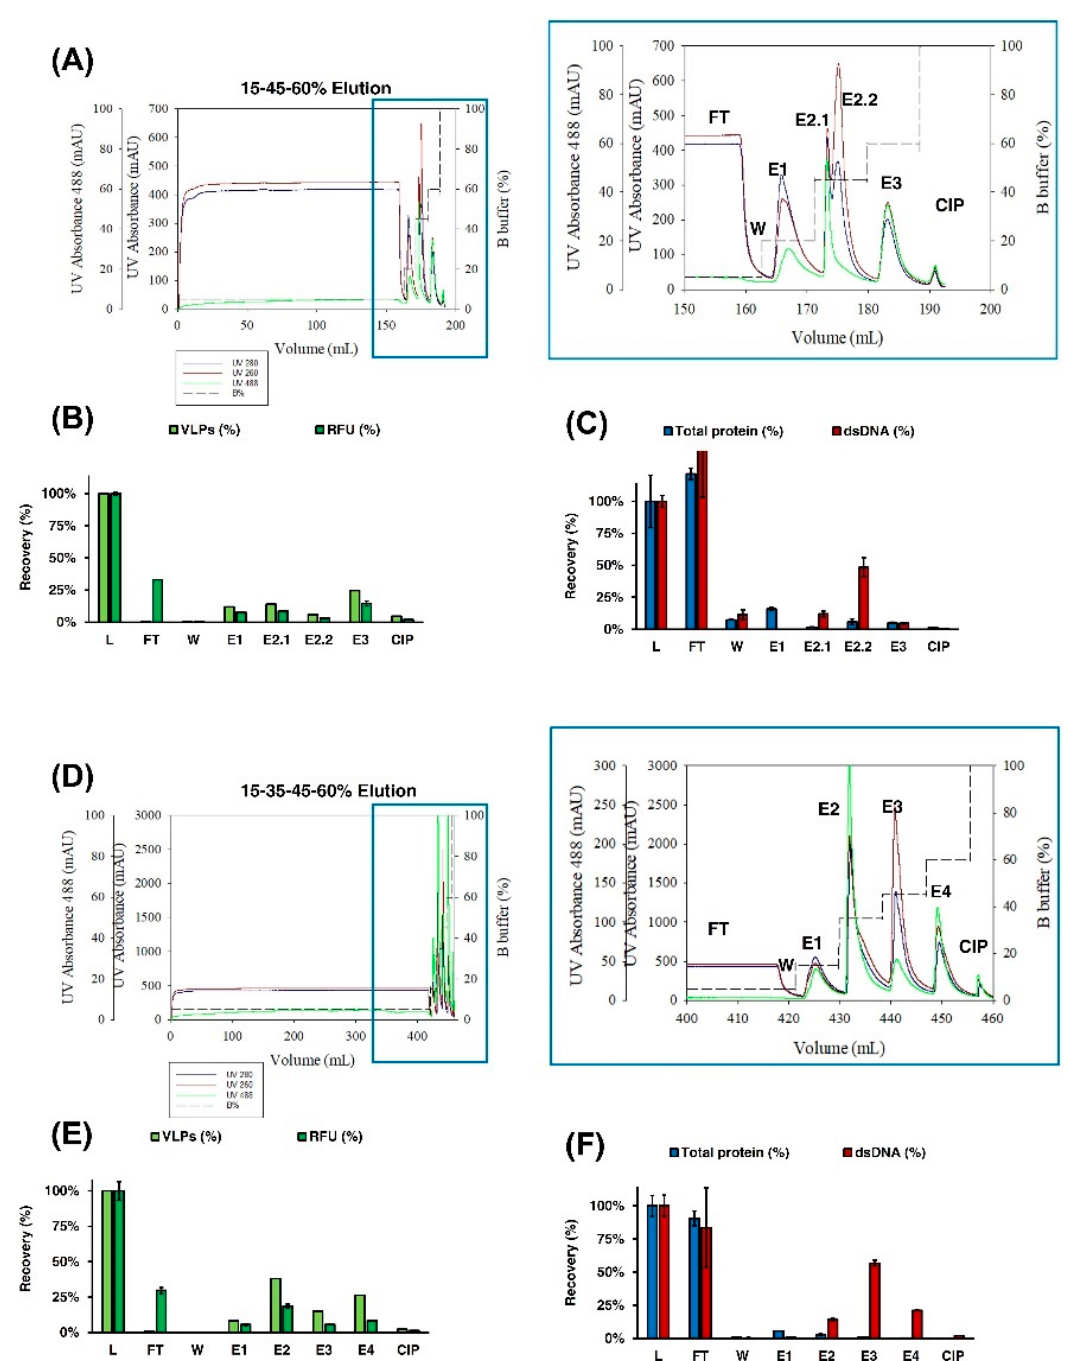
Figure 4. Optimization of IEX chromatography. ( A , D ) Chromatogram of the step gradient purification of Gag-eGFP VLP supernatant using a Mustang ® QXT. A total load of 150 mL was eluted in a step gradient of 15%–45%–60% of B buffer ( A ), or a total load of 413 mL was eluted in a step gradient of 15%–35%–45%–60% of B buffer ( D ), respectively. The recovery of VLP nanoparticle concentration measured by flow virometry (VLPs) and relative fluorescent units (RFU) ( B , E ) and total protein and dsDNA content ( C , F ) were also assessed, respectively. L: load material; FT: flowthrough; W: wash; E1-E3: pooled fractions for peaks 1–3 and CIP: cleaning in place with 2 M NaCl.